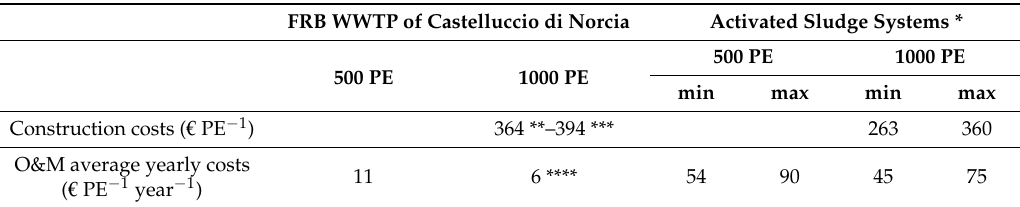
Table 7. Comparison of construction and O&M costs of the FRB WWTP of Castelluccio di Norcia with typical costs for activated sludge systems in Italian context.